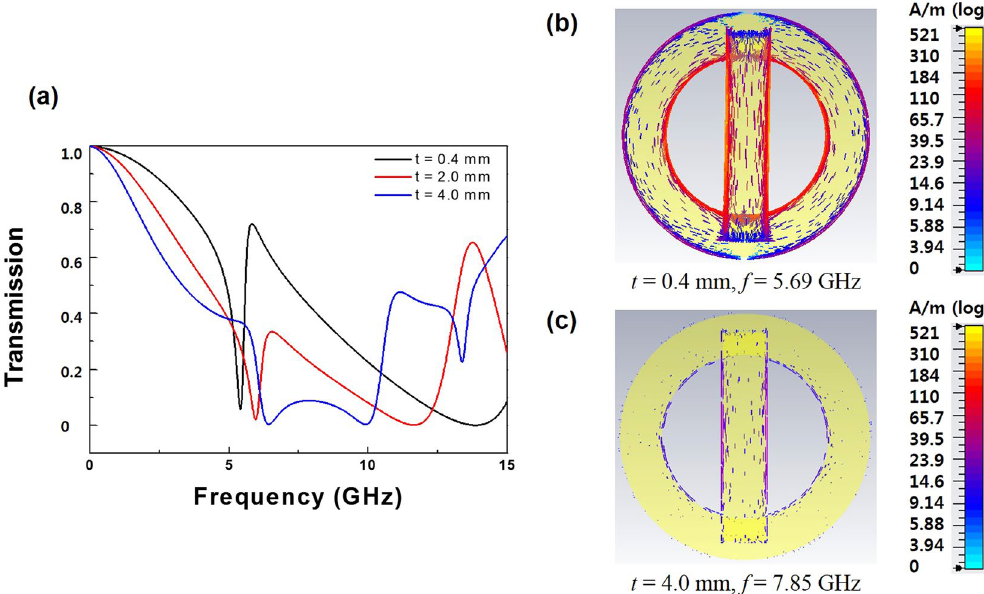
Figure 4. ( a ) Simulated spectra of the transmission at the normal incidence for the CWR-RR structure by varying the thickness of FR4 substrate. Surface-current distributions at ( b ) t = 0.4 mm and 5.69 GHz, and ( c ) t = 4.0 mm and 7.85